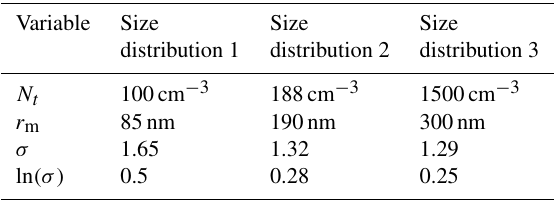
aerosol size distributions used throughout the